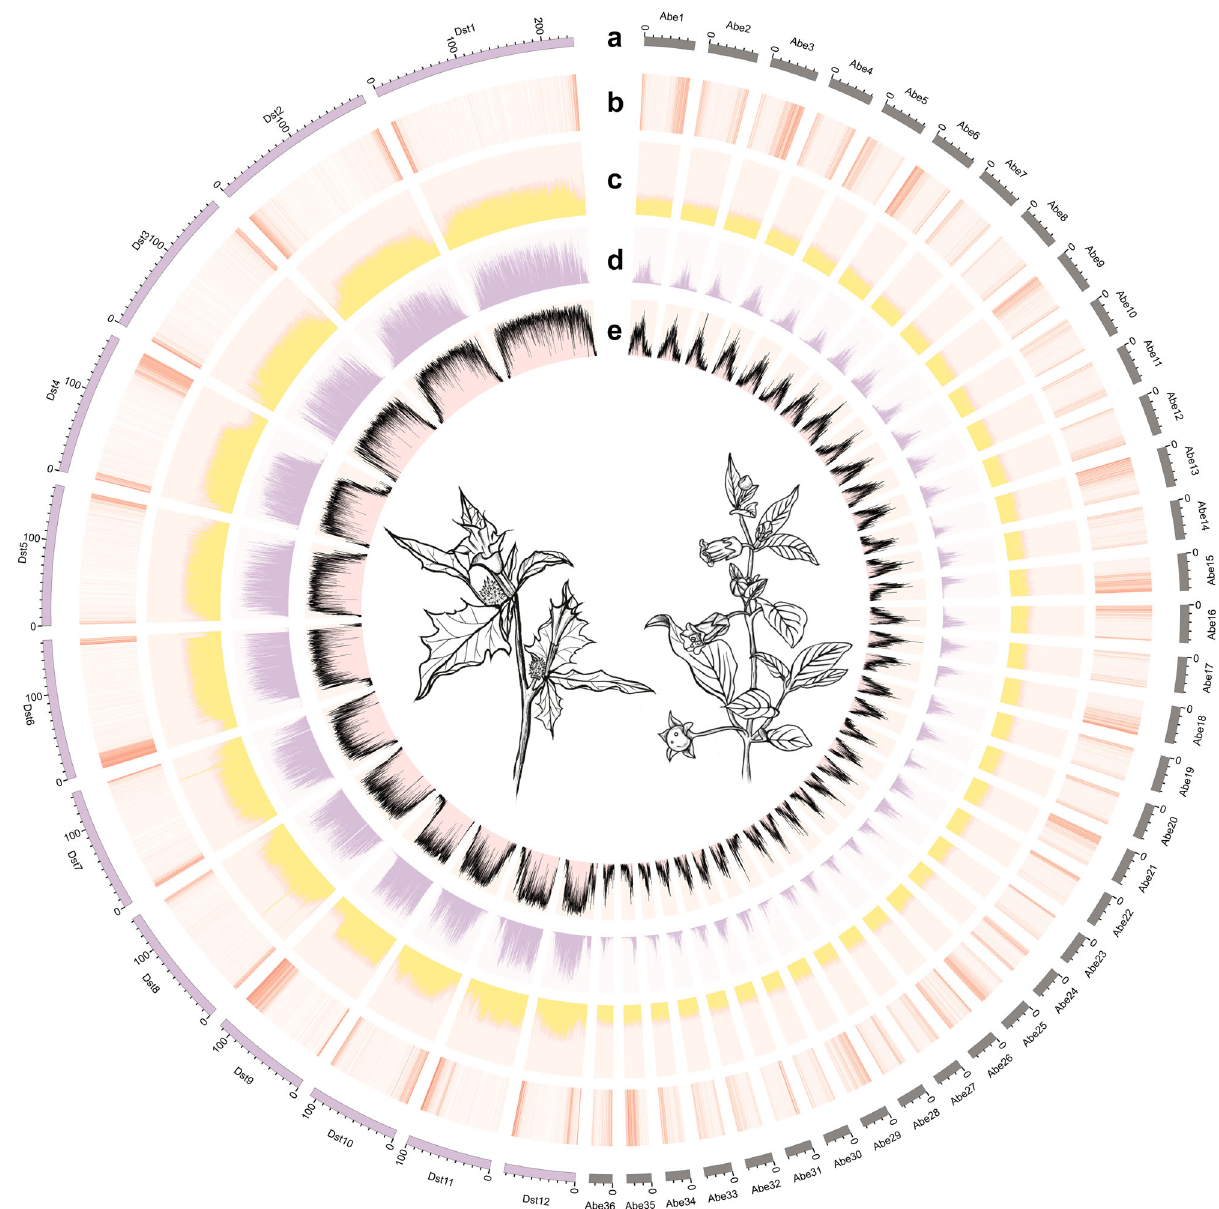
Fig. 1 | An overview of the genomic features of A. belladonna and D. stramo- nium . a The genomic landscape of the 36 A. belladonna pseudochromosomes (right) and 12 D. stramonium pseudochromosomes (left). All density information